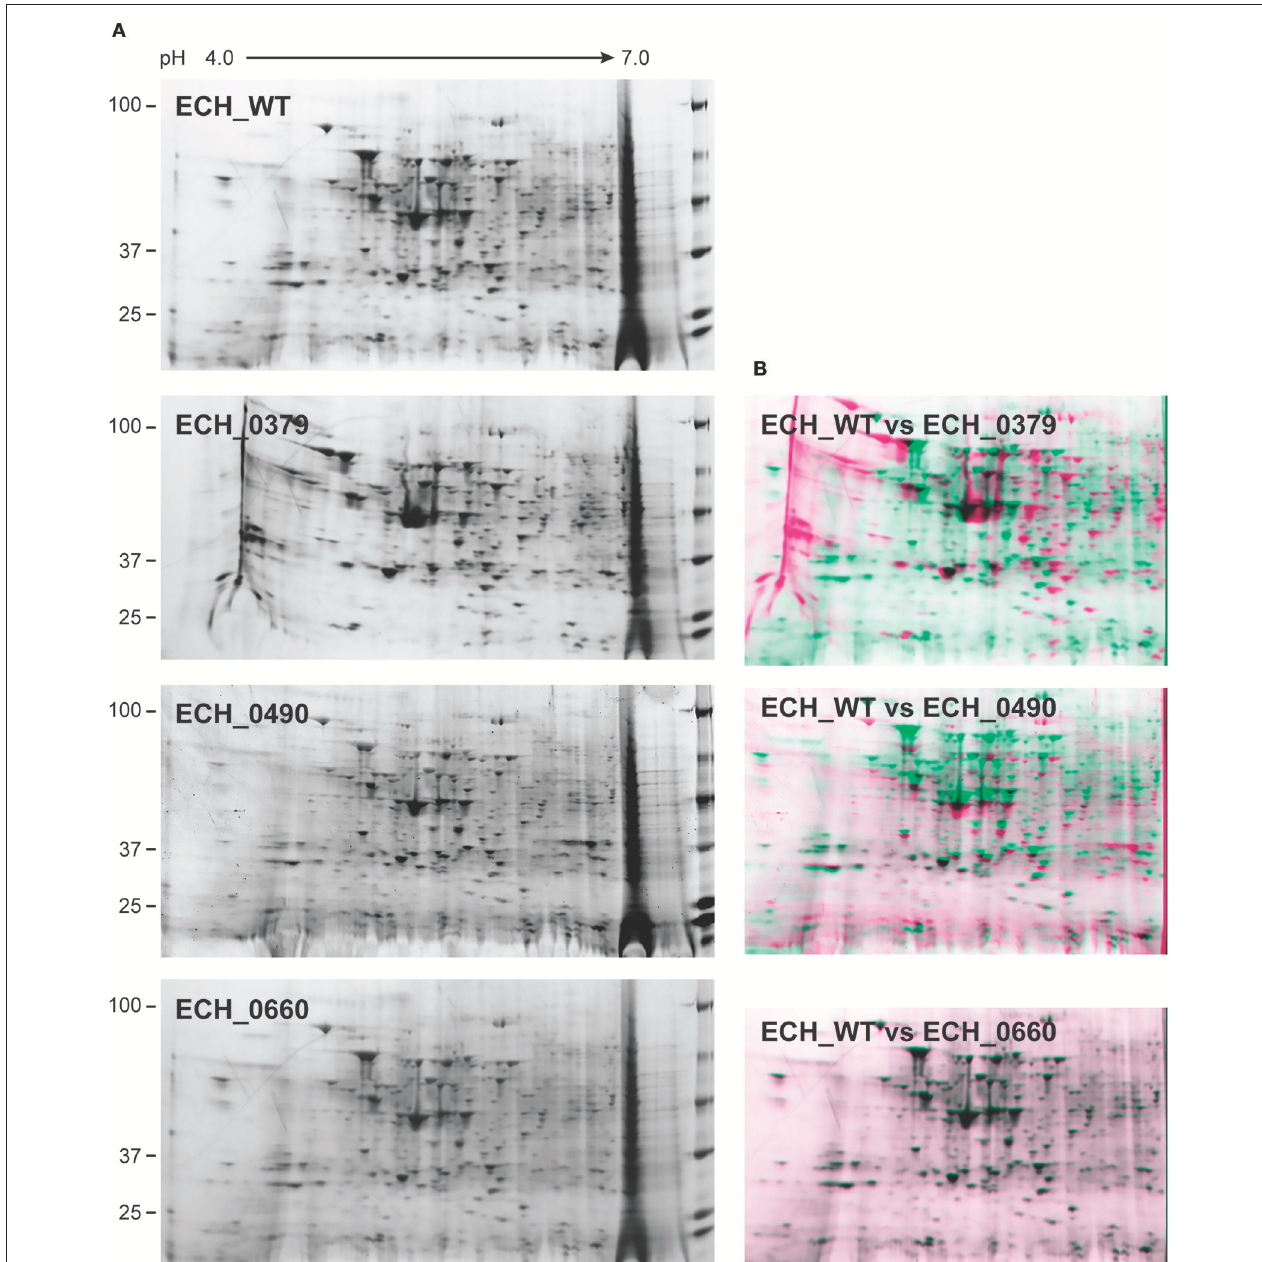
FIGURE 2 | 2D gel resolved protein expression maps of E. chaffeensis wildtype and its three mutants. (A) One hundred µ g of proteins were separated on 11 cm, pH 4–7 linear IPG strips and second dimension SDS-PAGE was performed using 4–20% Criterion gels. Gels were stained with SYPRO Ruby protein stain. The pH and molecular weights of the proteins are shown on the top and left side of the gel images, respectively. (B) The 2D proteomes of mutants were compared with the wildtype E. chaffeensis proteome using the PD Quest TM Advanced 2-D Analysis software where we observed 89% match between wildtype and ECH_0660, followed by ECH_0490 having matched at 64% and the lowest matching of 55% for the ECH_0379 with the wildtype E. chaffeensis proteome.